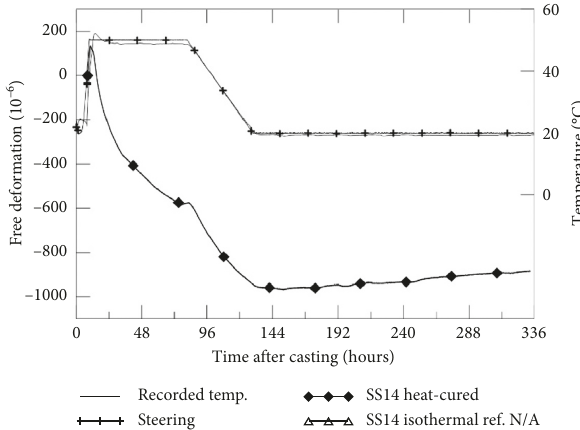
Figure 3: Free deformations and temperature development recorded on SS14 heat-cured sample. Recorded temp. Figure 2: Deformation recorded on steel pipe (nonzeroed).